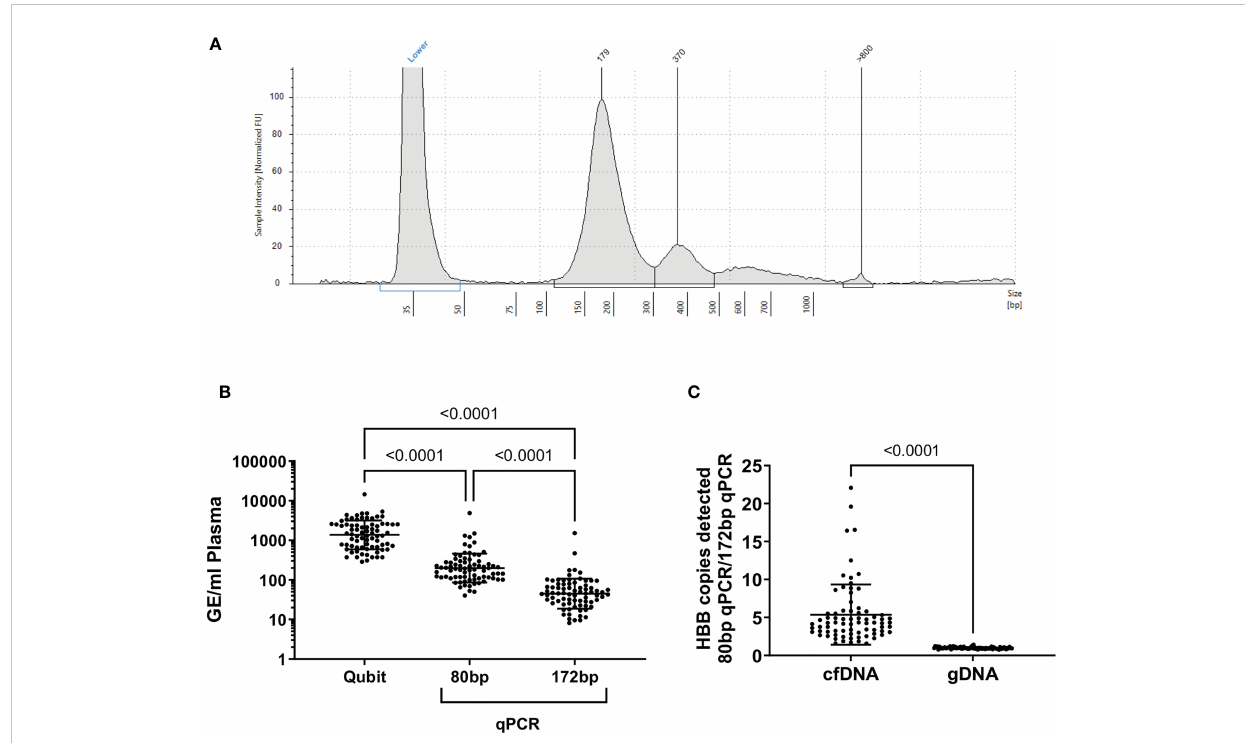
FIGURE 1 Quality assessment of cfDNA puri fi ed from plasma. (A) Representative electrophoretogram of puri fi ed plasma cfDNA (cfDNA screentape) (B) GE/ml of plasma calculated from each quanti fi cation method applied to plasma cfDNA. (C) Ratio of HBB copies detected with the 80bp HBB primers: 172 bp primers. In genomic DNA, there was no difference in the number of HBB copies detected with either primer (p=0.3, one sample t test). In cfDNA samples, signi fi cantly more HBB copies were detected with the 80 bp primer set than the 172 bp primer set, indicating that the cfDNA was highly fragmented. Statistical tests: (B) Friedman test with Dunn ’ s multiple comparisons test (two-tailed, 95% con fi dence interval), (C) Wilcoxon matched- pairs signed rank test (two-tailed, 95% con fi dence interval), using GraphPad